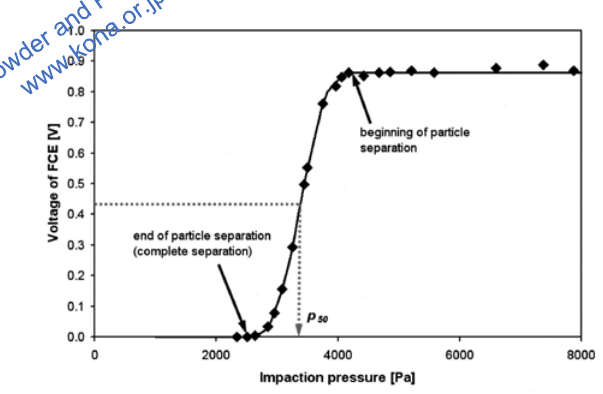
Fig. 4 Measured separation curve for 454-nm DEHS droplets. Fig. 5 Behaviour of parameter Y as a function of particles size for par- ticles with solid (Ag, Pt) and liquid surfaces